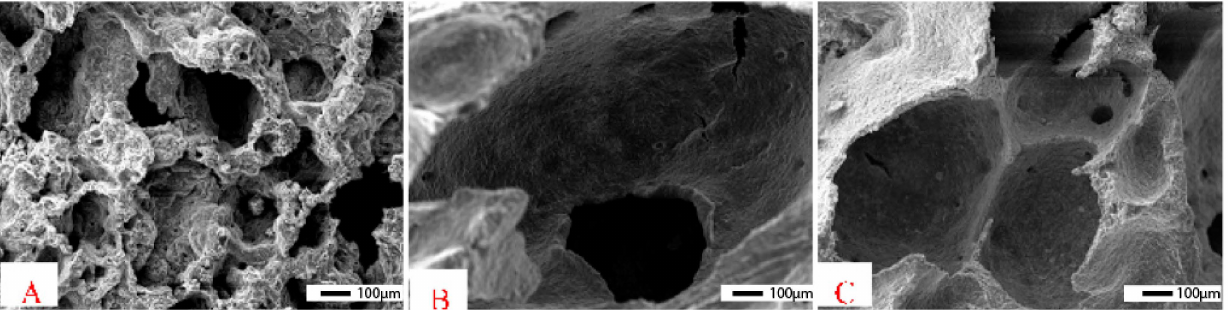
Figure 13. SEM micrographs of metakaolin-based porous geopolymers using aluminium powder and cured at 80 ◦ C for 4 h, Aluminium powder/pre-geopolymer formulation ratios: 1:1 ( A ), 1:1,5 ( B ), and 1:3 ( C )